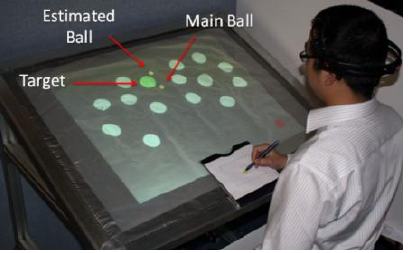
Fig. 10. Superflick interaction test using a BCI for auto-correction. Source: [32].